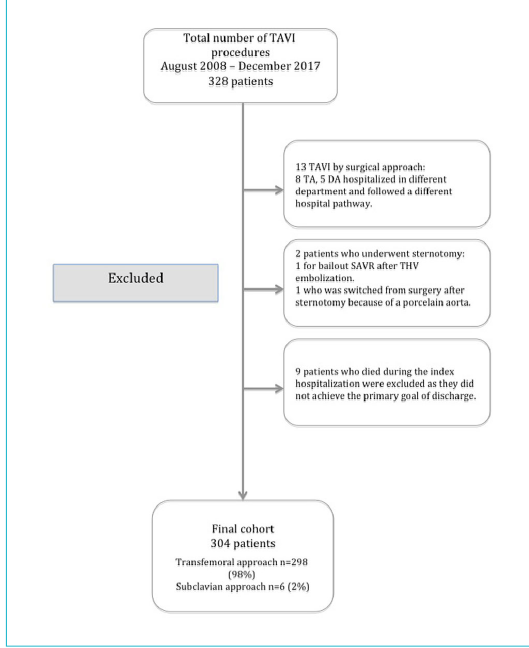
Figure 1: Study population flow chart and patients excluded from the final cohort according to the predefined study criteria.DA = di- rect aortic; SAVR = surgical aortic valve replacement; TA = trans- apical; TAVI = transcatheter aortic valve implantation; THV =